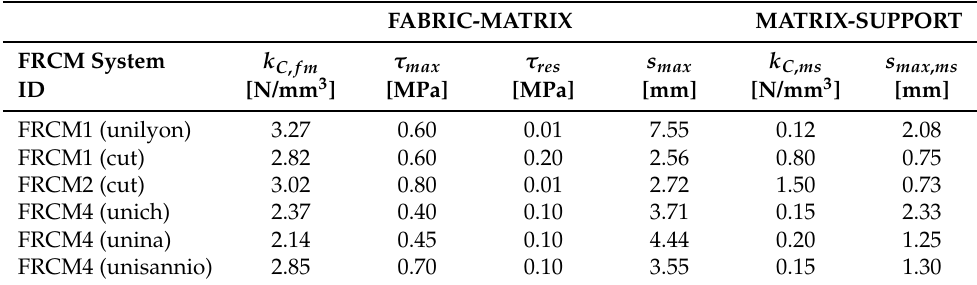
Table 4. Interface